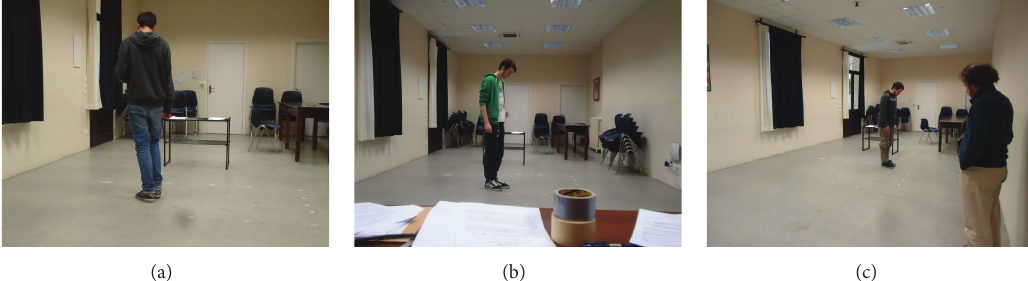
Figure 1: The Harmonic Walk while being tested by three high school students at the Catholic Institute “Barbarigo,” Padova (Italy).